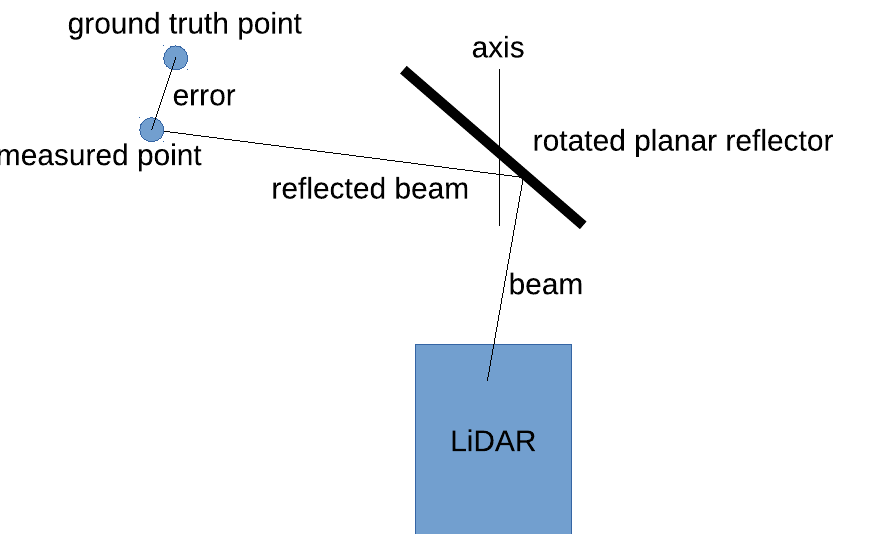
Figure 1. Scheme of the affordable 3D scanning system composed of lidar and rotating planar reflector. The goal of the calibration procedure is to minimize the sum of errors squared between measured and ground truth points obtained woth